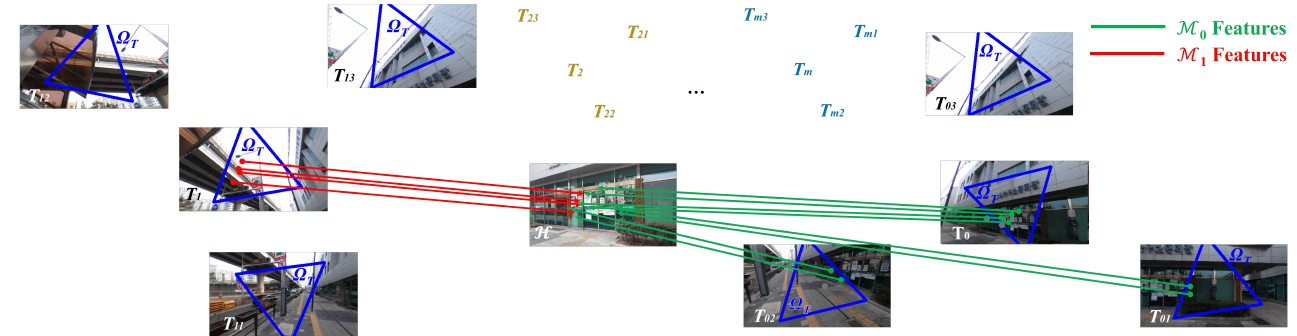
Figure 5. False Tangent Image (False TI) Detection. We perform feature extraction-matching between all tangent images (TIs) T m and the high angular resolution planar image (HPI) H . We use the resulting accumulated matched features (AMF) M m to identify false TI. The AMF M m is the union of the main tangent image (MTI) T m features and their neighborhoods (NTI) T mn (see Section 3.4). We expect that false TI has a low accumulated features number |M m | despite having a high feature number by itself. The TI T 1 exhibits such characteristics: 4 self-matched features and 4 for M 1 . On the contrary, T 0 has high |M 0 | : 4 self-matched features and 8 AMF. Thus, T 1 is not a false TI. We only show T 0 and T 1 and three NTI for both of them for